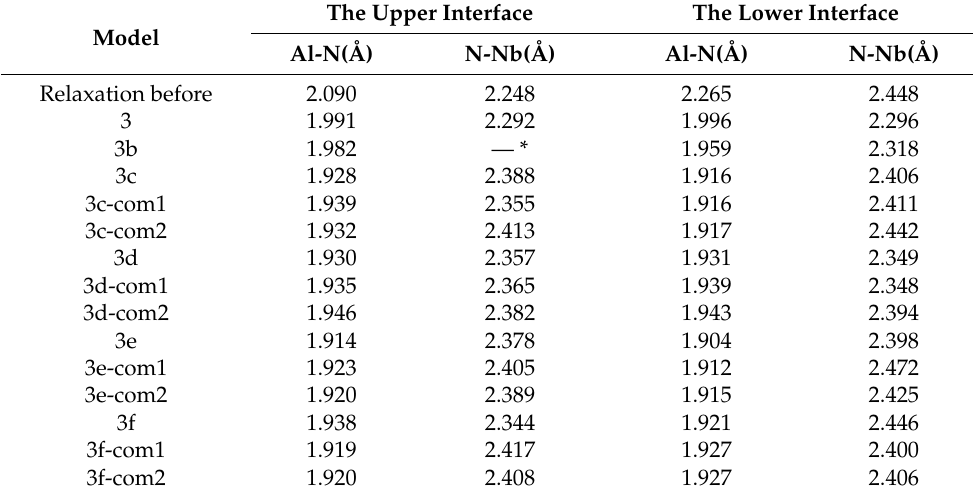
Table 1. Comparison results of the spacing between the layers at the interface before and after relaxation. The Upper Model